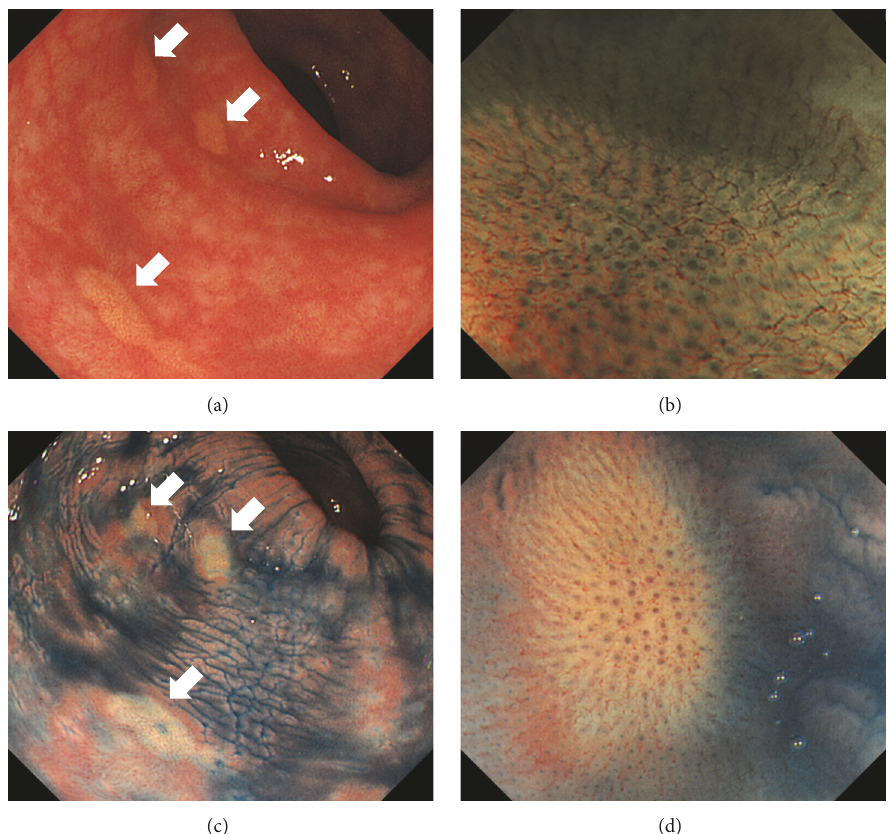
Figure 1: Colonoscopy images of case 1. Multiple yellowish spots measuring approximately 3 to 5mm are seen in the rectum (a). Magnifying observation with narrow-band imaging reveals intact pits of the rectal mucosa (b). Indigo-carmine spraying emphasizes the whitish to yellowish color of the lesions (c,